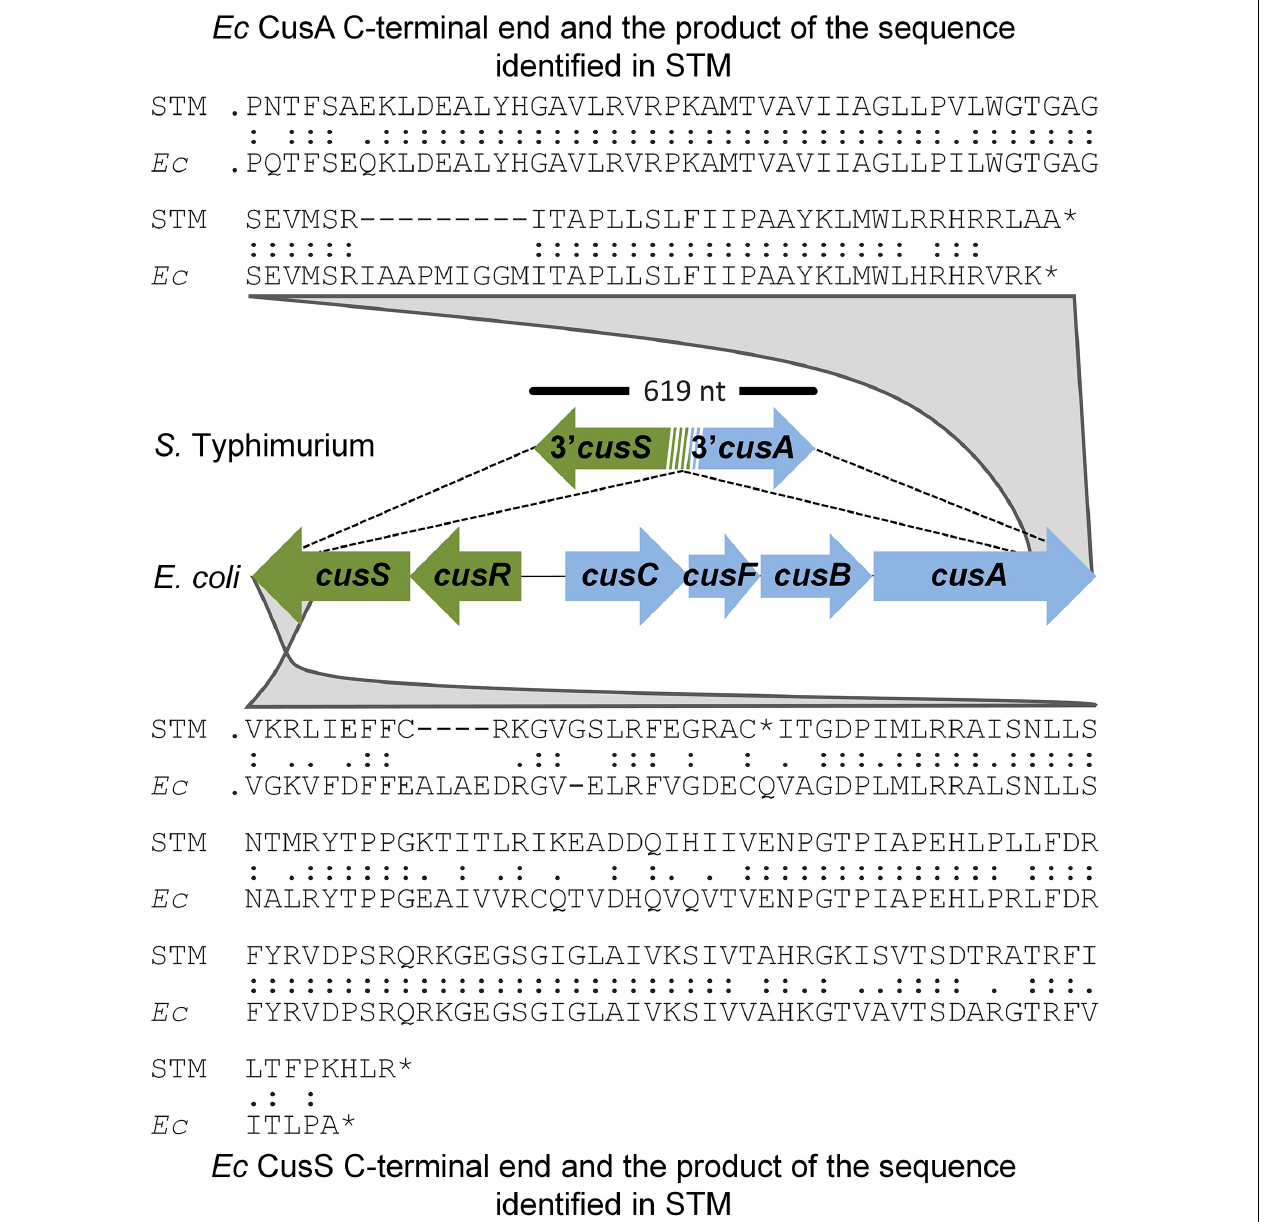
FIGURE 1 | Cus remnants in the Salmonella Typhimurium chromosome. The figure shows the 619-bp region harboring remnants of the outermost ends of the cus locus identified in the S . Typhimurium (STM) genome and the homology with the Escherichia coli (Ec) CusA and CusS C-termini.